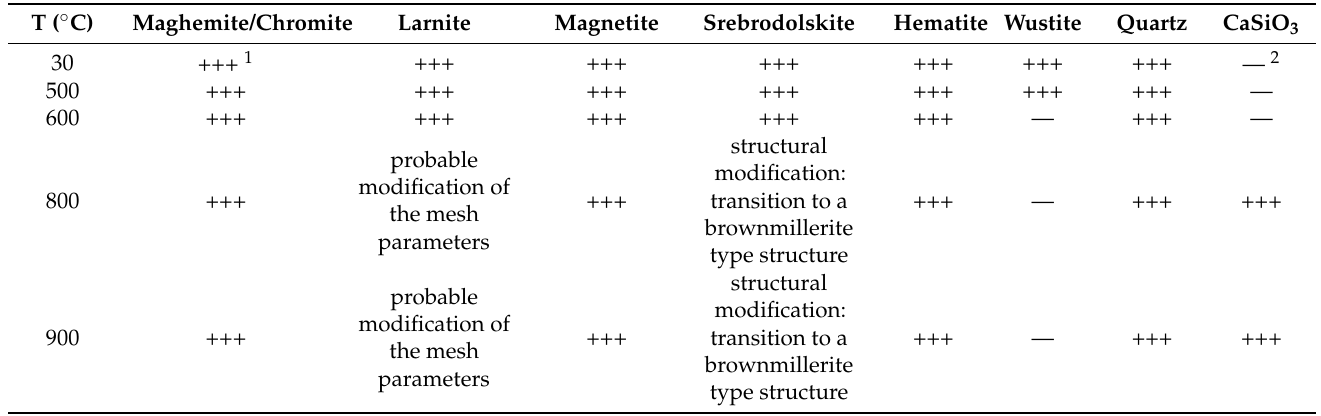
Table 4. XRD evaluation of EAF slag modifications during treatment in air from 30 to 900 ◦ C. T ( ◦ C) Maghemite/Chromite